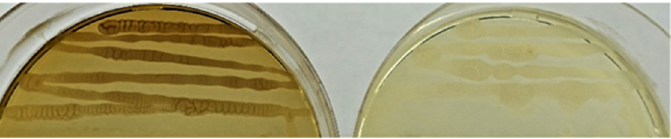
Figure 3 . Brown pigment forming strain Sa24-2R Bacillus sp. (left); strain Se5R Bacillus sp.—does not synthesize pigment (right).